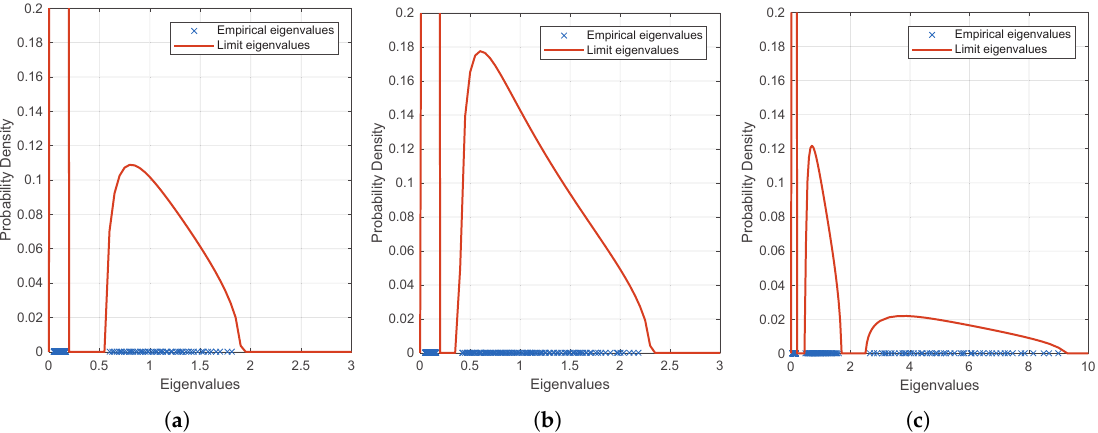
Figure 2. ( a ) Empirical distribution of eigenvalues of massive MIMO when there is no eavesdropper = 10, M = 10, σ 2 = 0.1. ( b ) There is one active eavesdropper with equal received p b = 1, T M K